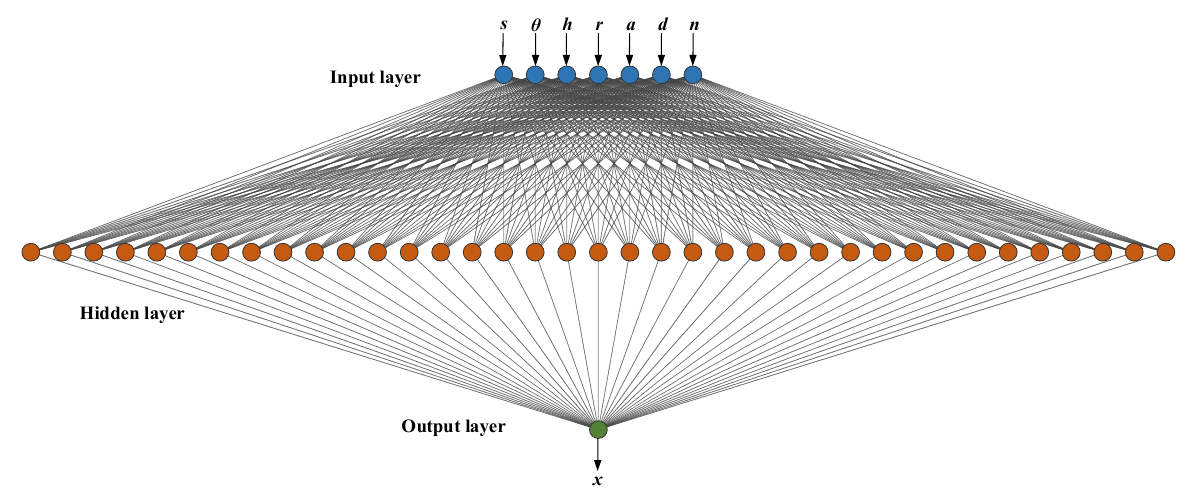
Figure 12. Most appropriate structure of the proposed ELM model.